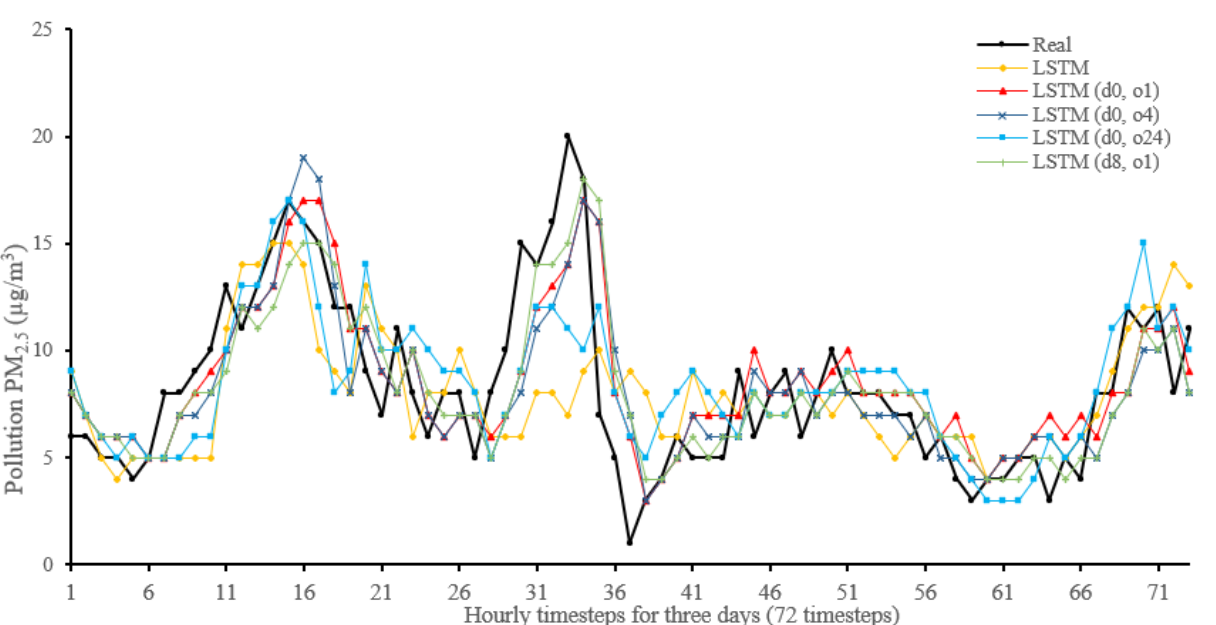
Figure 17. Real vs. LSTM and its NARX variants in part of the seventh iteration results for the Manchester dataset.